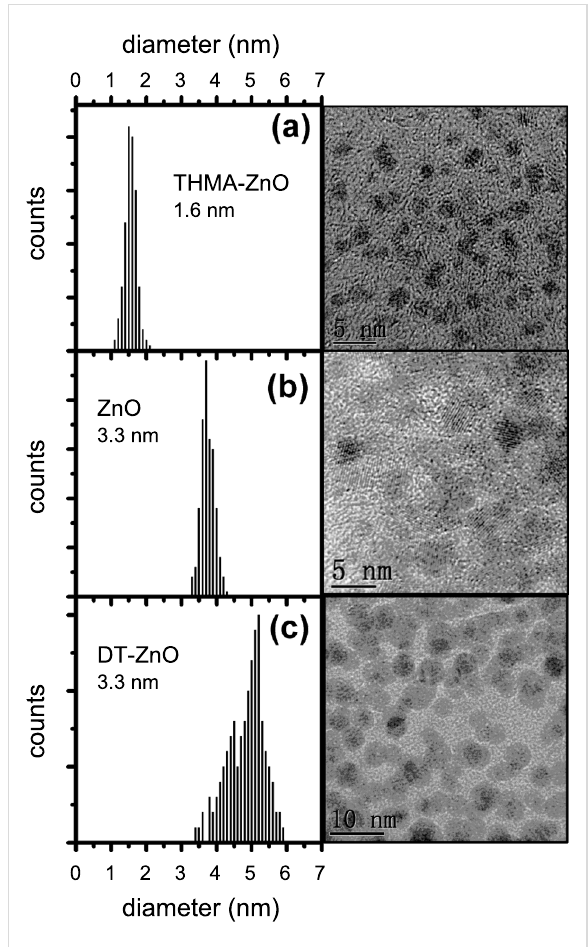
Figure 2: Transmission electron microscopy images and size-distribu- tion analyses of ZnO nanocrystals after heating under reflux in ethanol for 30 min, for (a) THMA-functionalised ZnO nanoparticles; (b) ZnO NPs; and (c) DT-functionalised ZnO NPs.